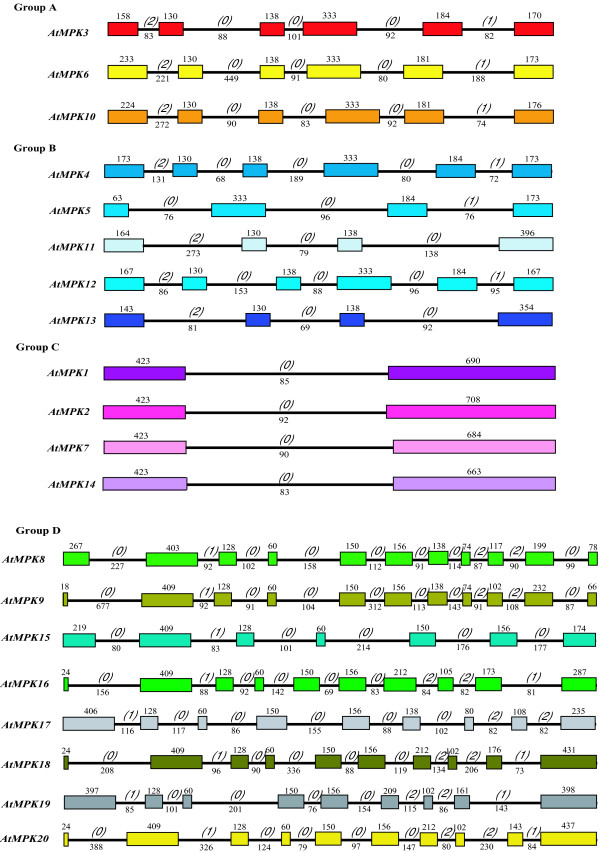
Intron and exon organization of Arabidopsis MAPK genes (AtMPKs). Introns and exons are represented by black lines and colored boxes respectively. The length in base pairs of each intron and exon is also indicated. Numbers between brackets correspond to the intron phase. AtMPKs have been grouped according to phylogenetic classification [39].